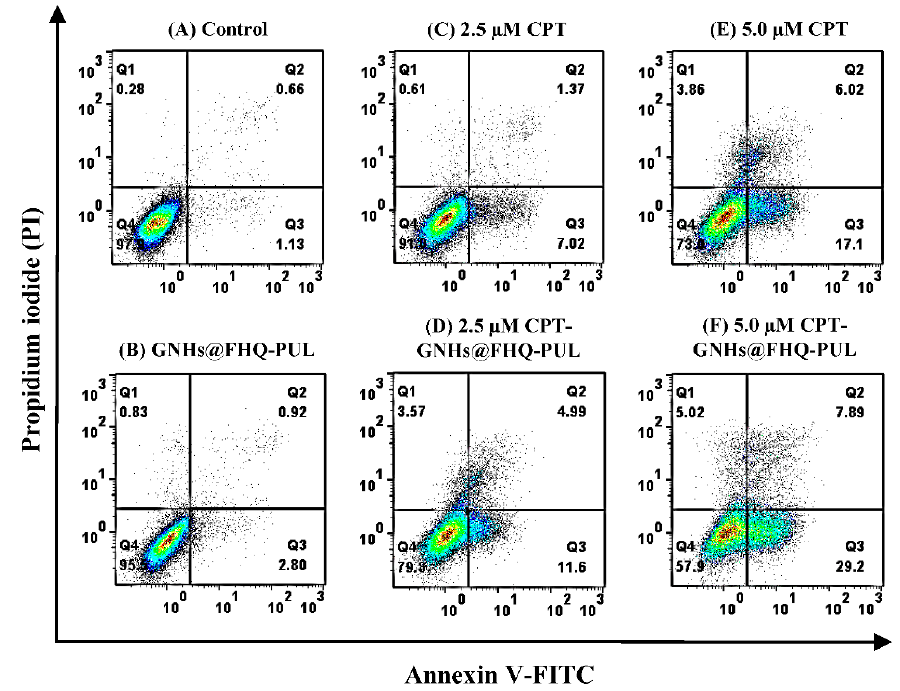
Figure 10. Flow cytometric analysis of Chago-k1 cells after treatment with ( A ) control, ( B ) GNHs@FHQ-PUL, ( C , D ) CPT, or ( E , F ) CPT-GNHs@FHQ-PUL at 37 °C for 12 h, as detected by An- nexin V-FITC/PI staining assay (Q1 represents necrotic cells, Q2 represents late apoptotic cells, Q3 represents early apoptotic cells and Q4 represents live